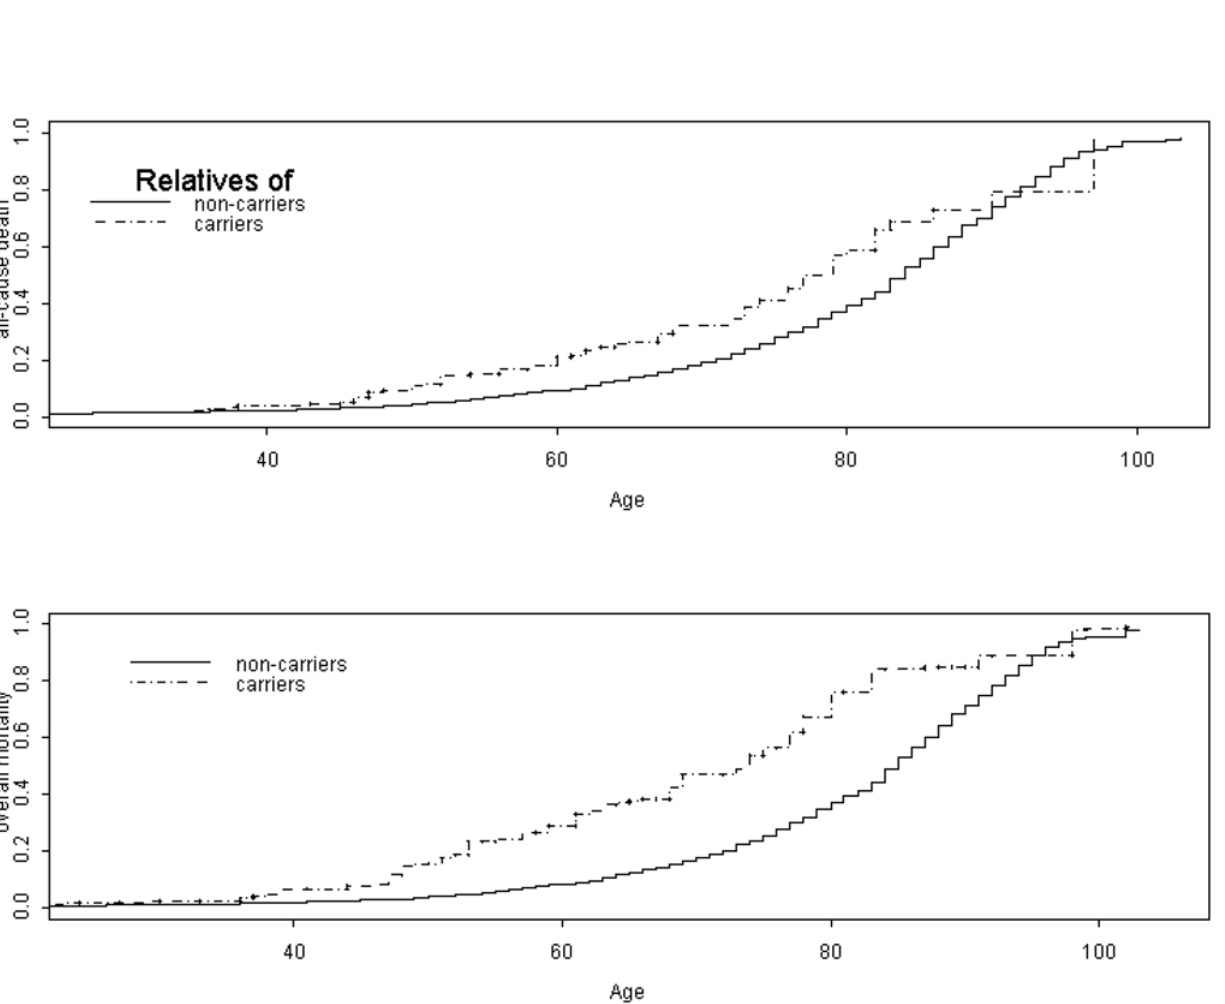
Participants Parents of Siblings of Children of